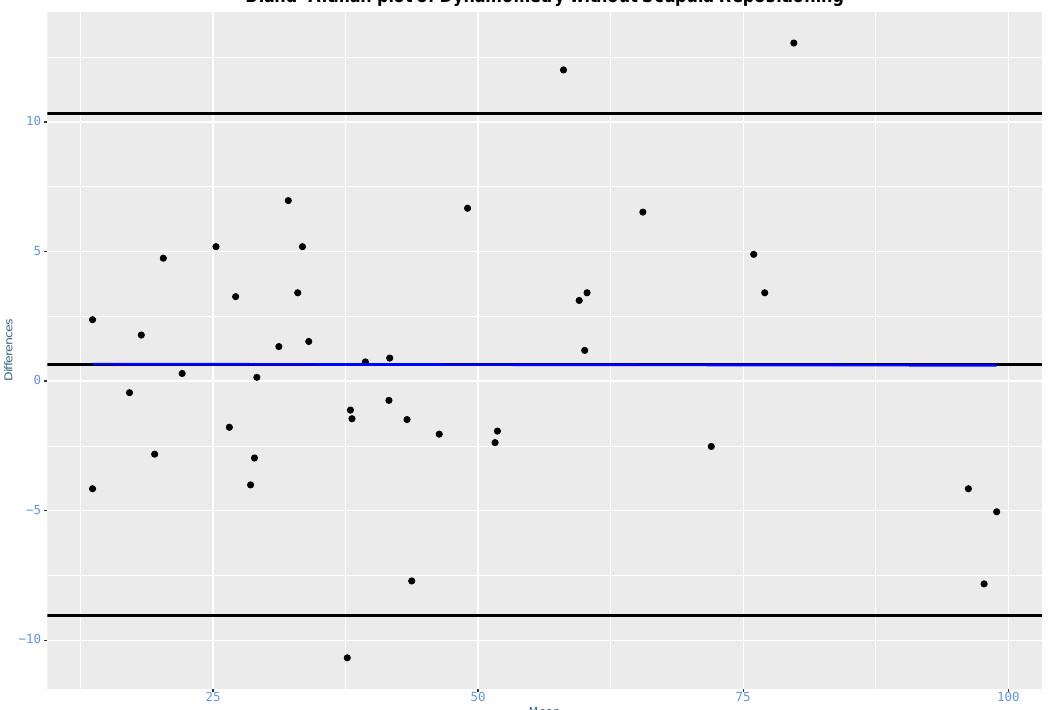
Figure 3. Bland–Altman plot for dynamometry without scapula repositioning. Blue line = regression line.